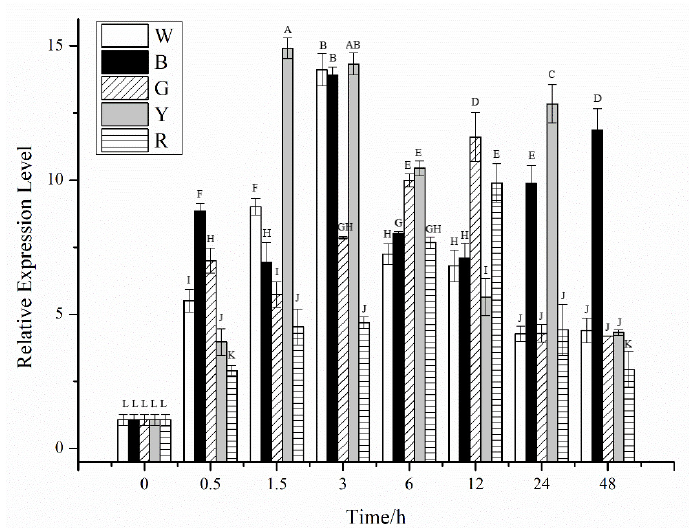
Figure 5. Relative expression of CiPlant-CRY1 in different lights for different times. W: white light, B: blue light, G: green light, Y: yellow light, R: red light. Standard error bars are shown, n = 3. Different capital letters indicate significant differences between different treatments ( p <